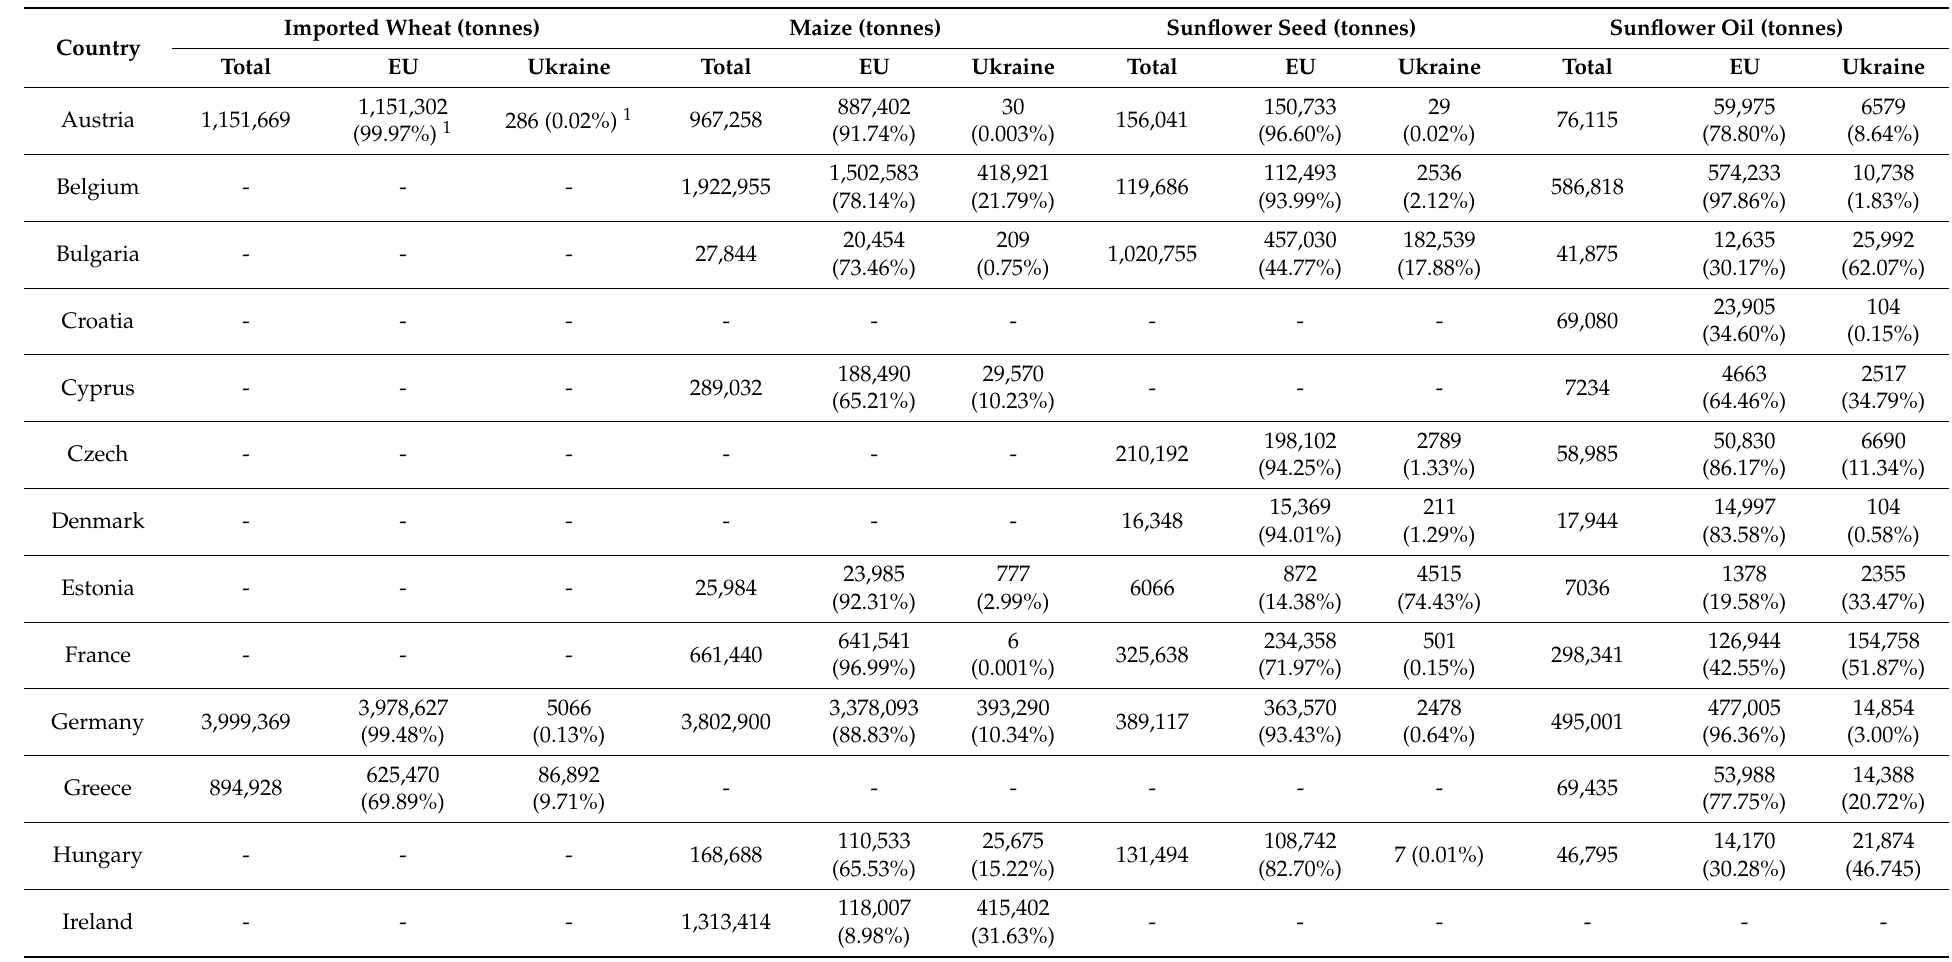
Table 3. Importation of Ukrainian and European wheat, maize, sunflower seed and oil in